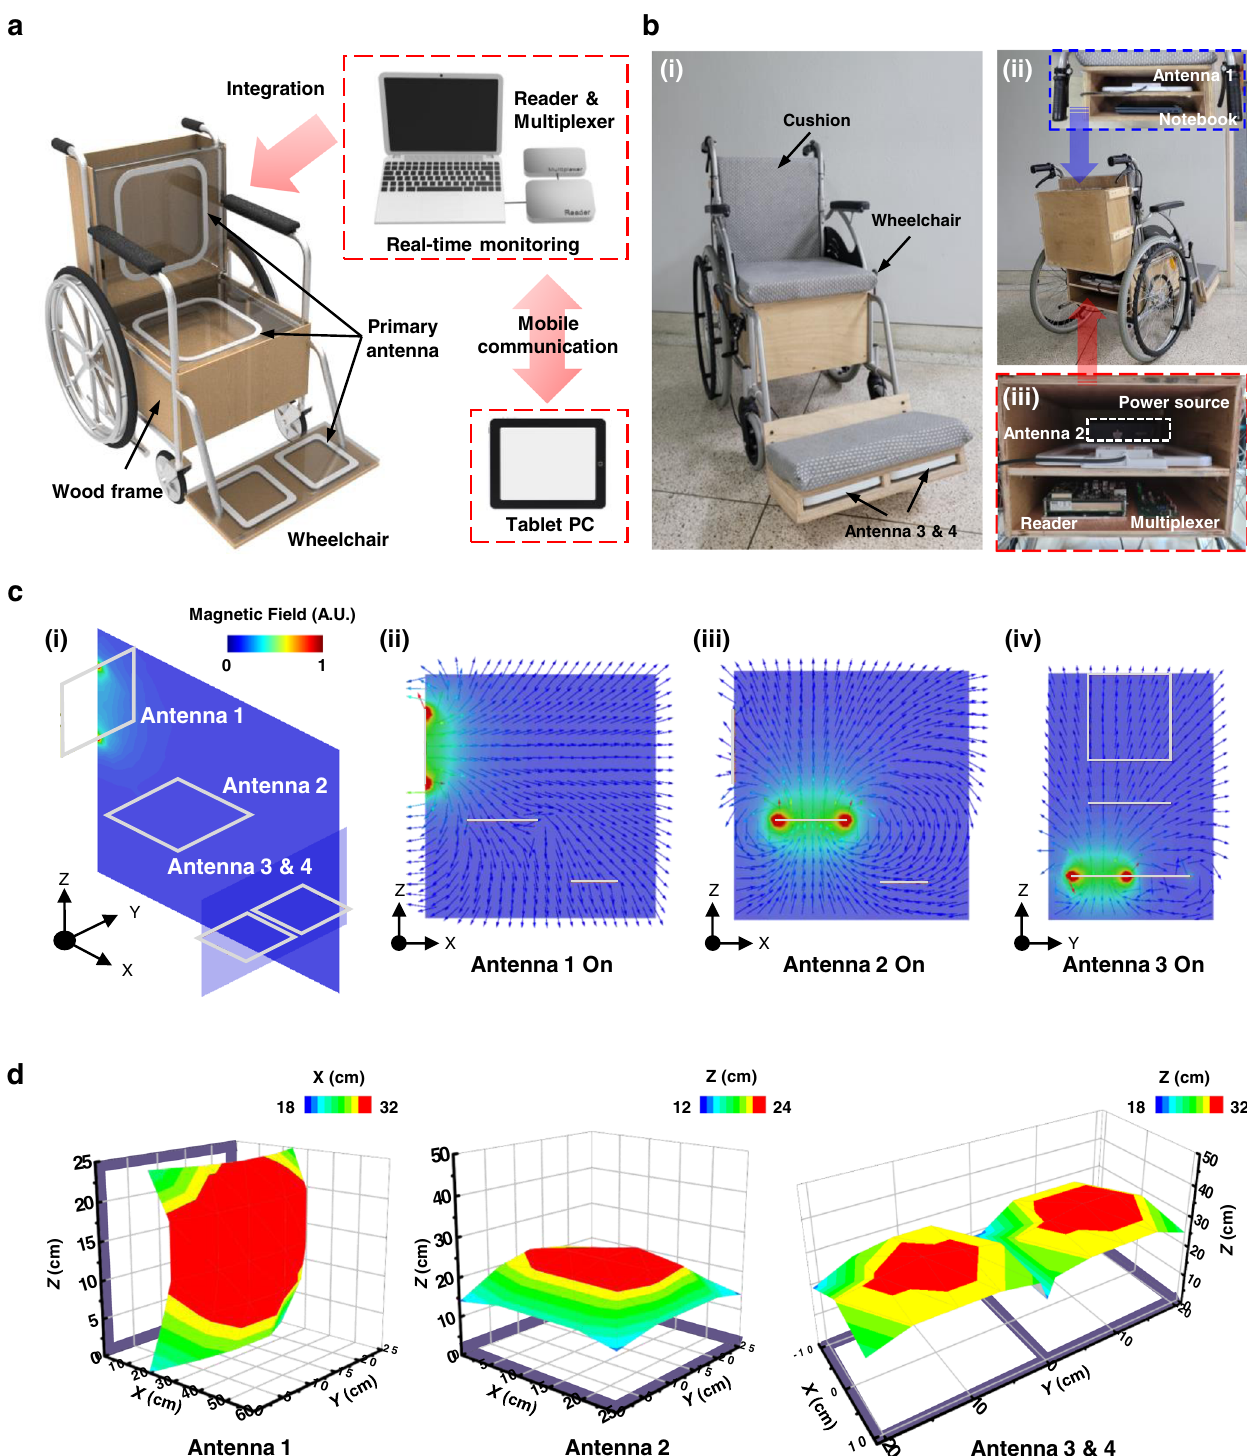
Fig. 3 Schematic illustrations and photographs of battery-free, wireless, movable sensing system. a Schematic illustration of the overall system integrated with a wheelchair. b Photographs of the movable system, including four primary antennas; multiplexer; antenna reader; notebook for real-time monitoring. c Magnetic fi eld distribution for multiplexed antenna con fi guration. d Experimental measurements of operating range for the four multiplexed interfaces between the skin and cushions for a subject sitting in a wheelchair. The system consists of four multiplexed antennas Figure 3a, b presents a schematic illustration and photographs of (antenna 1, behind the backrest; antenna 2, below the seat; and the movable sensing system for continuous monitoring of antennas 3 and 4, below the footrest) to provide full-body pressure, temperature, and hydration across many locations at